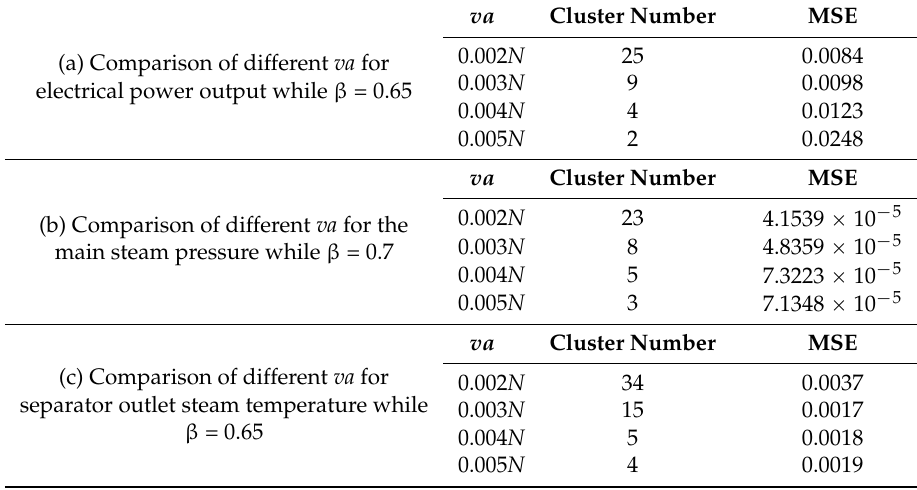
Table 2. Comparison of different va for different objects while β remains